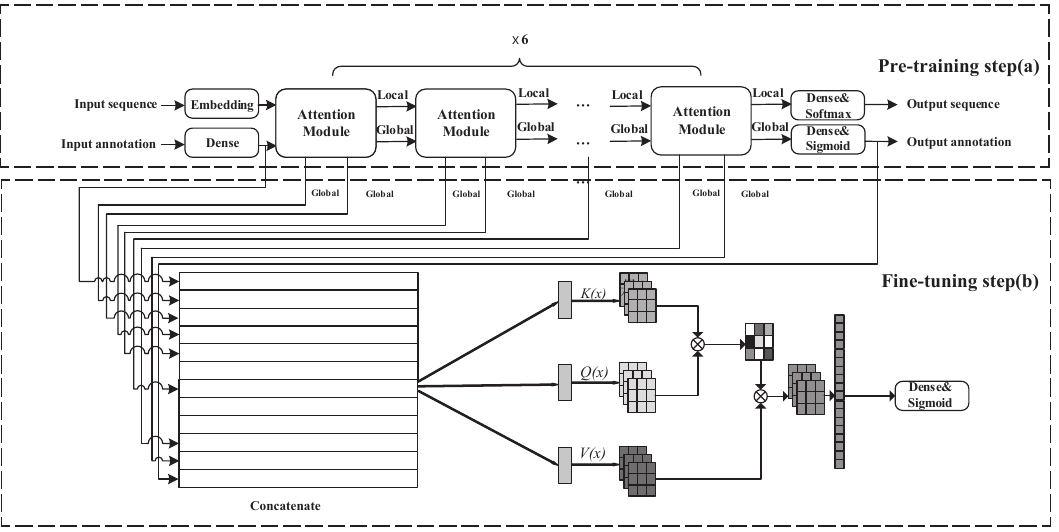
Figure 2. The architecture of TLCrys consists of two parts: ( a ) self-supervised pre-training protein representation models on protein sequences and Gene Ontology annotations. ( b ) supervised fine- tuning on protein crystallization dataset with pre-trained parameters.